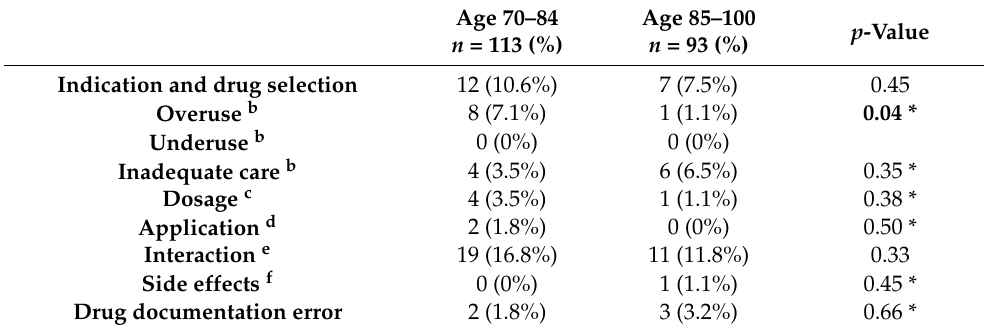
Table 4. Differences in potential ADRs a of antipsychotics in the two age groups by classification of pharmaceutical